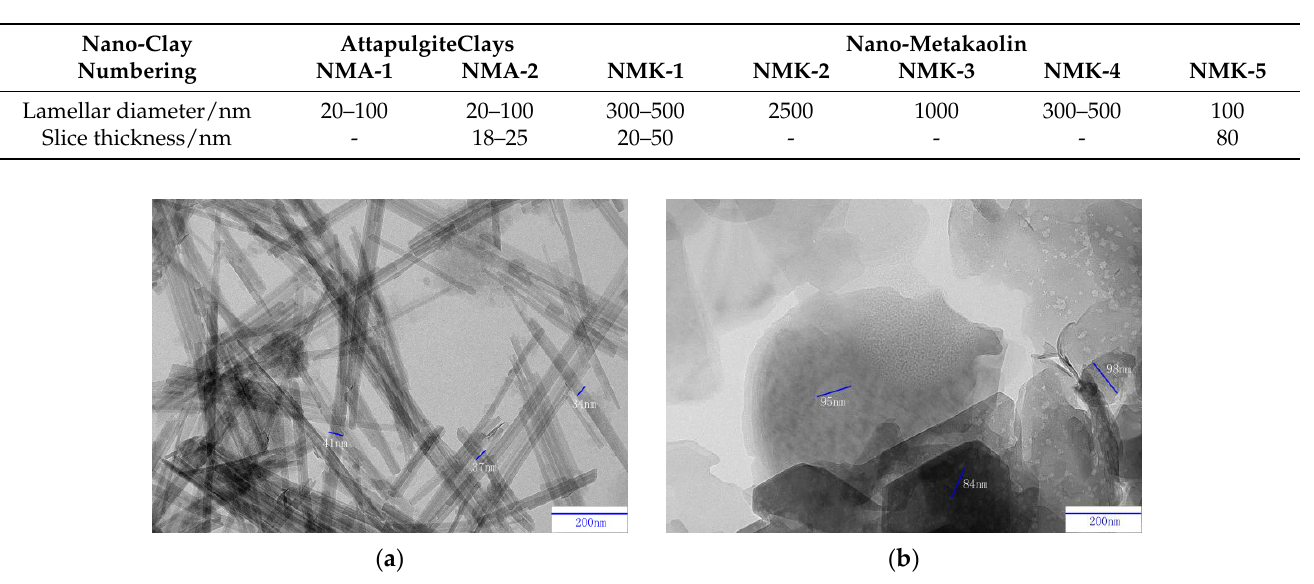
Figure 1. XRD spectra of nano-clay:( a )NMA; ( b )NMK.